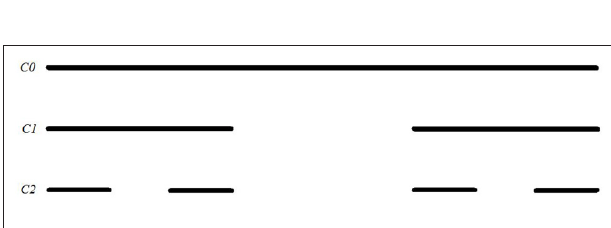
FIGURE 12 | Construction of Cantor set.